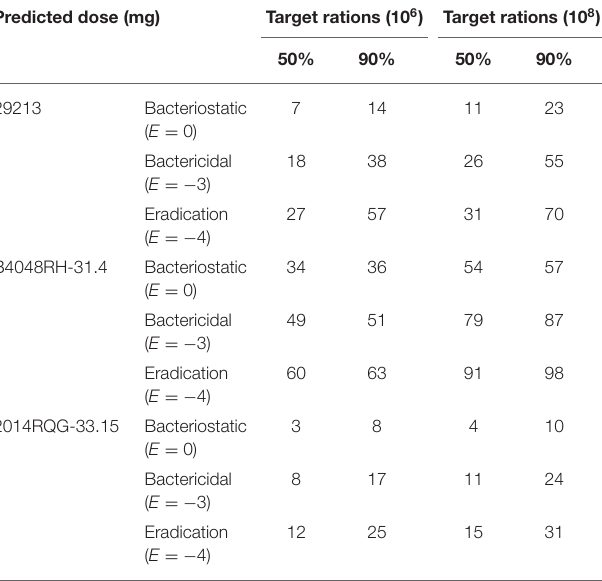
TABLE 3 | Predicted dose of cefquinome against S.aureus to reach 50%TAR, 90%TAR under different bacterial load (mg/gland/12h). Predicted dose